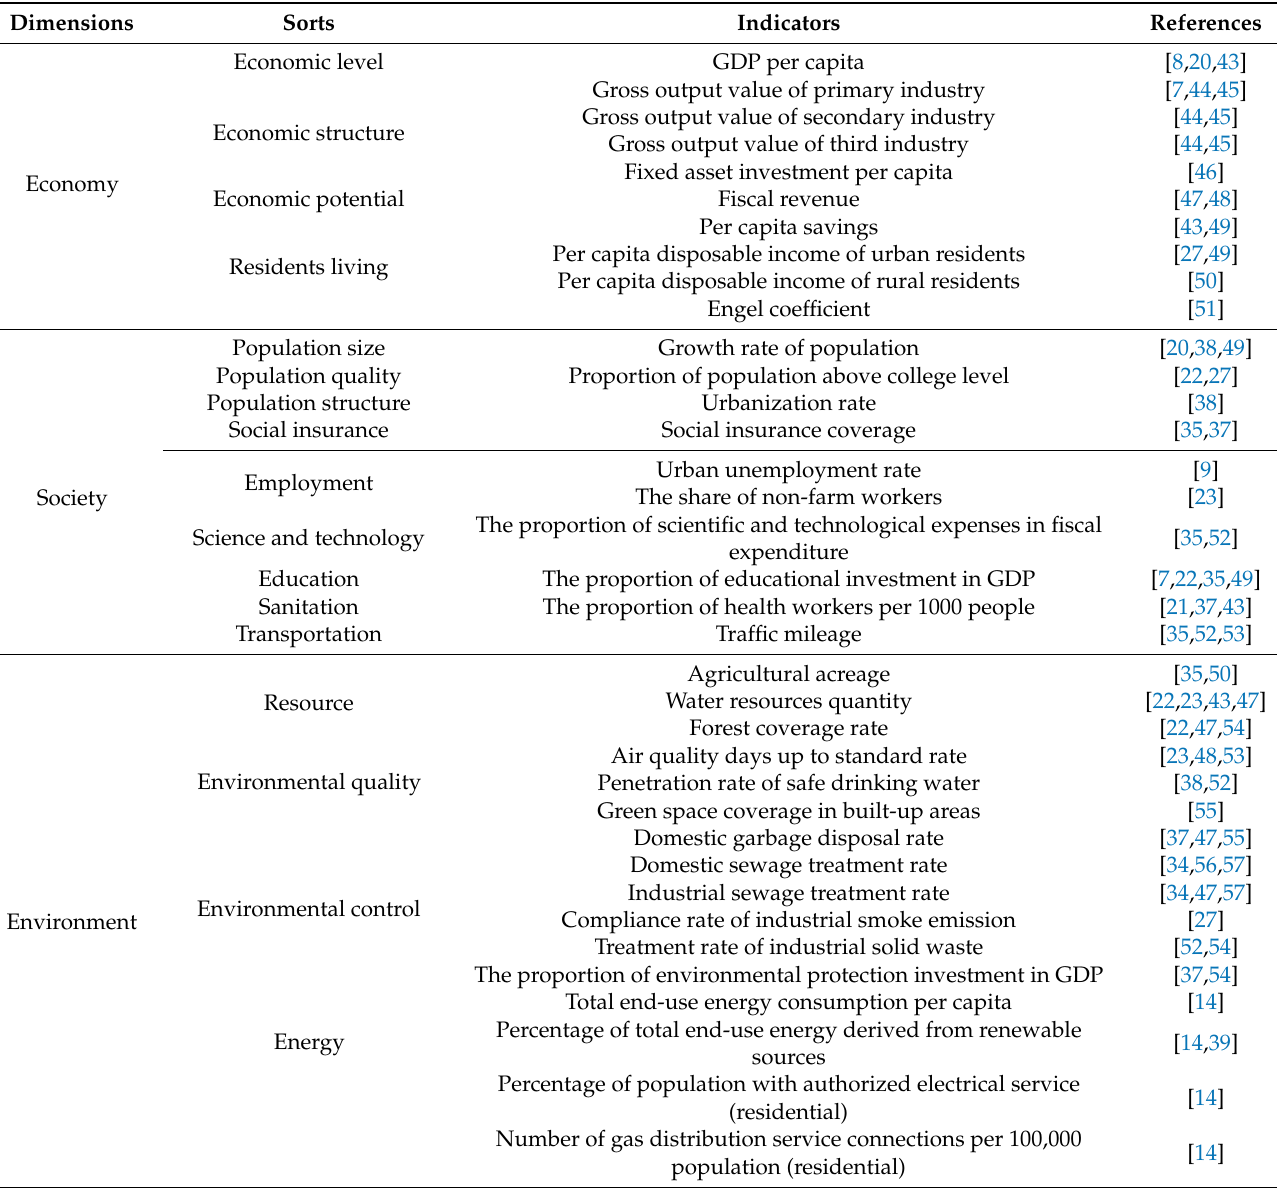
Table 2. Assessment indicators for township’s sustainable